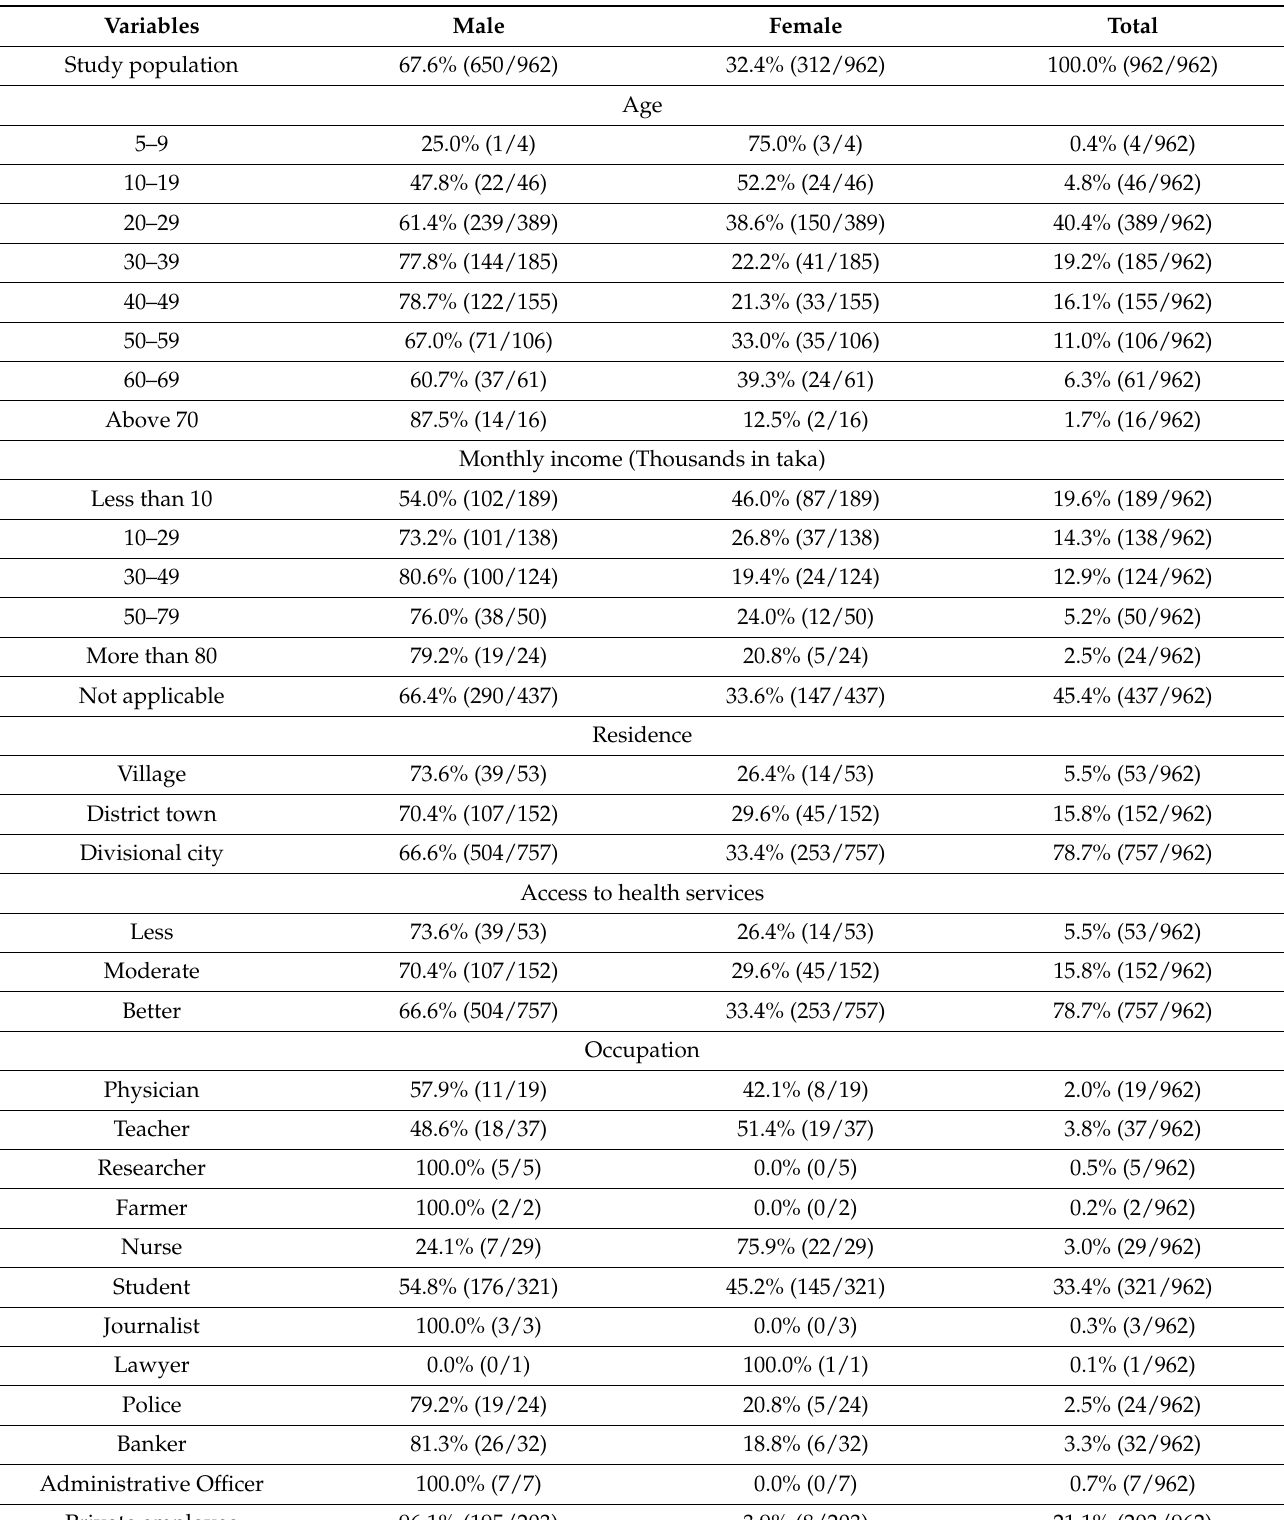
Table 1. Socio-demographic characteristics of the